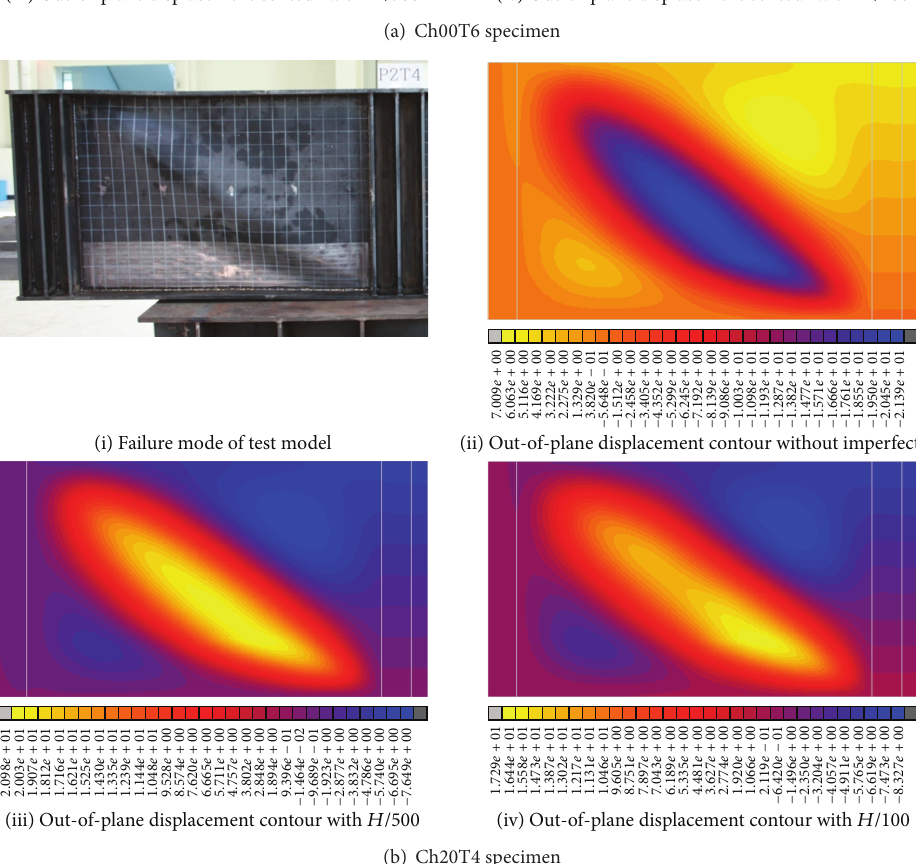
Figure 5: Failure mode comparisons of shear buckling test specimens depending on